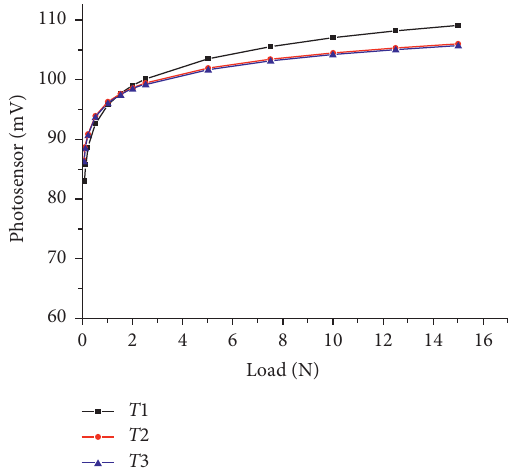
Figure 8: Response of the three proposed equations with load values from 0.05N to